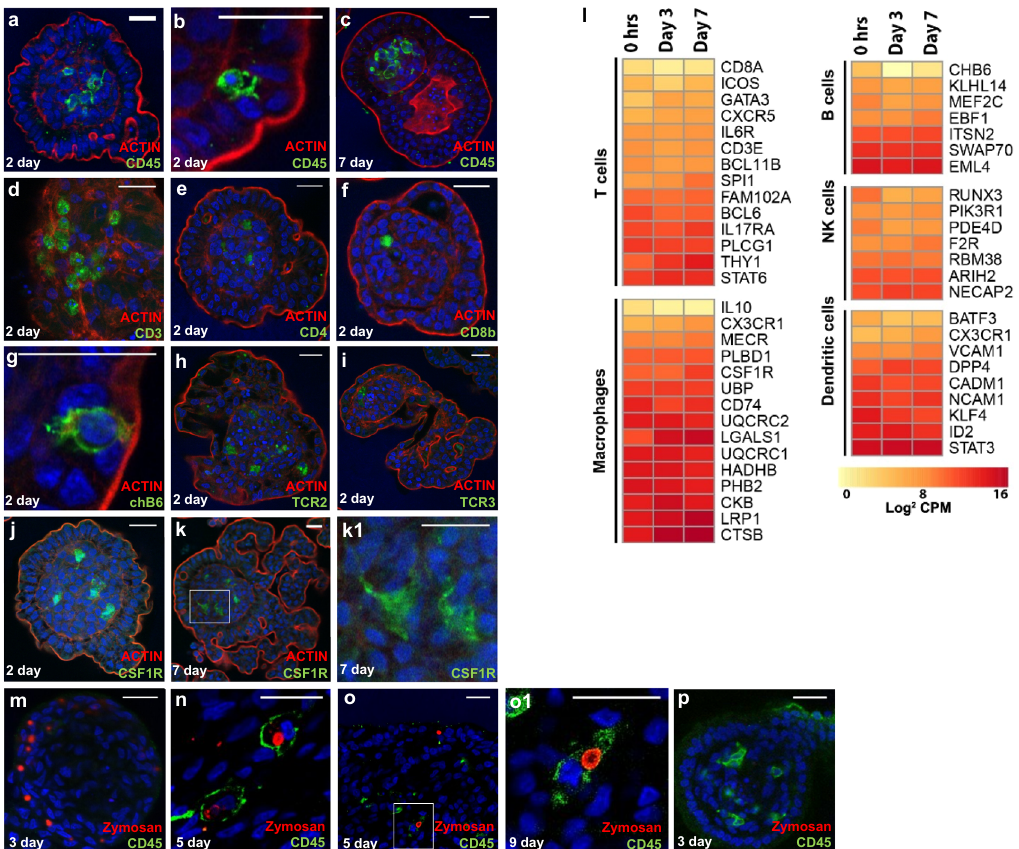
Fig. 6 Composition and functionality of immune cells within chicken enteroids. a – i Confocal images of chicken enteroids stained for leukocyte markers (green) at 2 or 7 days of culture. All enteroids are counterstained with DAPI (blue) and Phalloidin (red). a – c Enteroids stained for CD45 (green) showing leukocytes in the a , c lamina propria and b epithelium. Enteroids at 2 days of culture stained for d CD3, e CD4, f CD8 β , g chB6, h TCR2 (chicken αβ 1